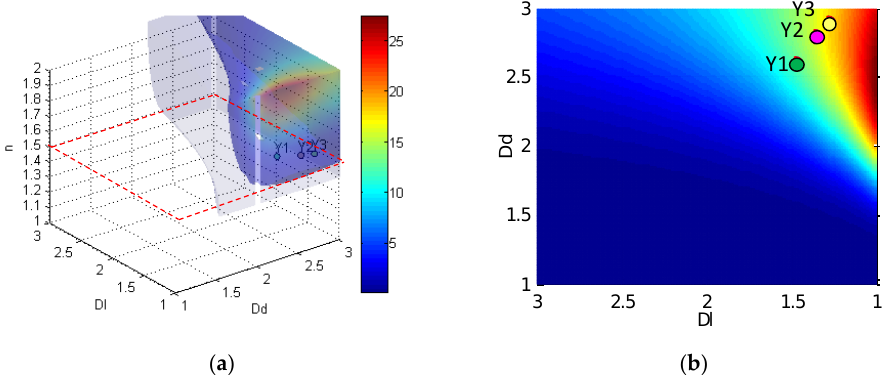
Figure 8. Imbibition parameter cube of fractal network system.